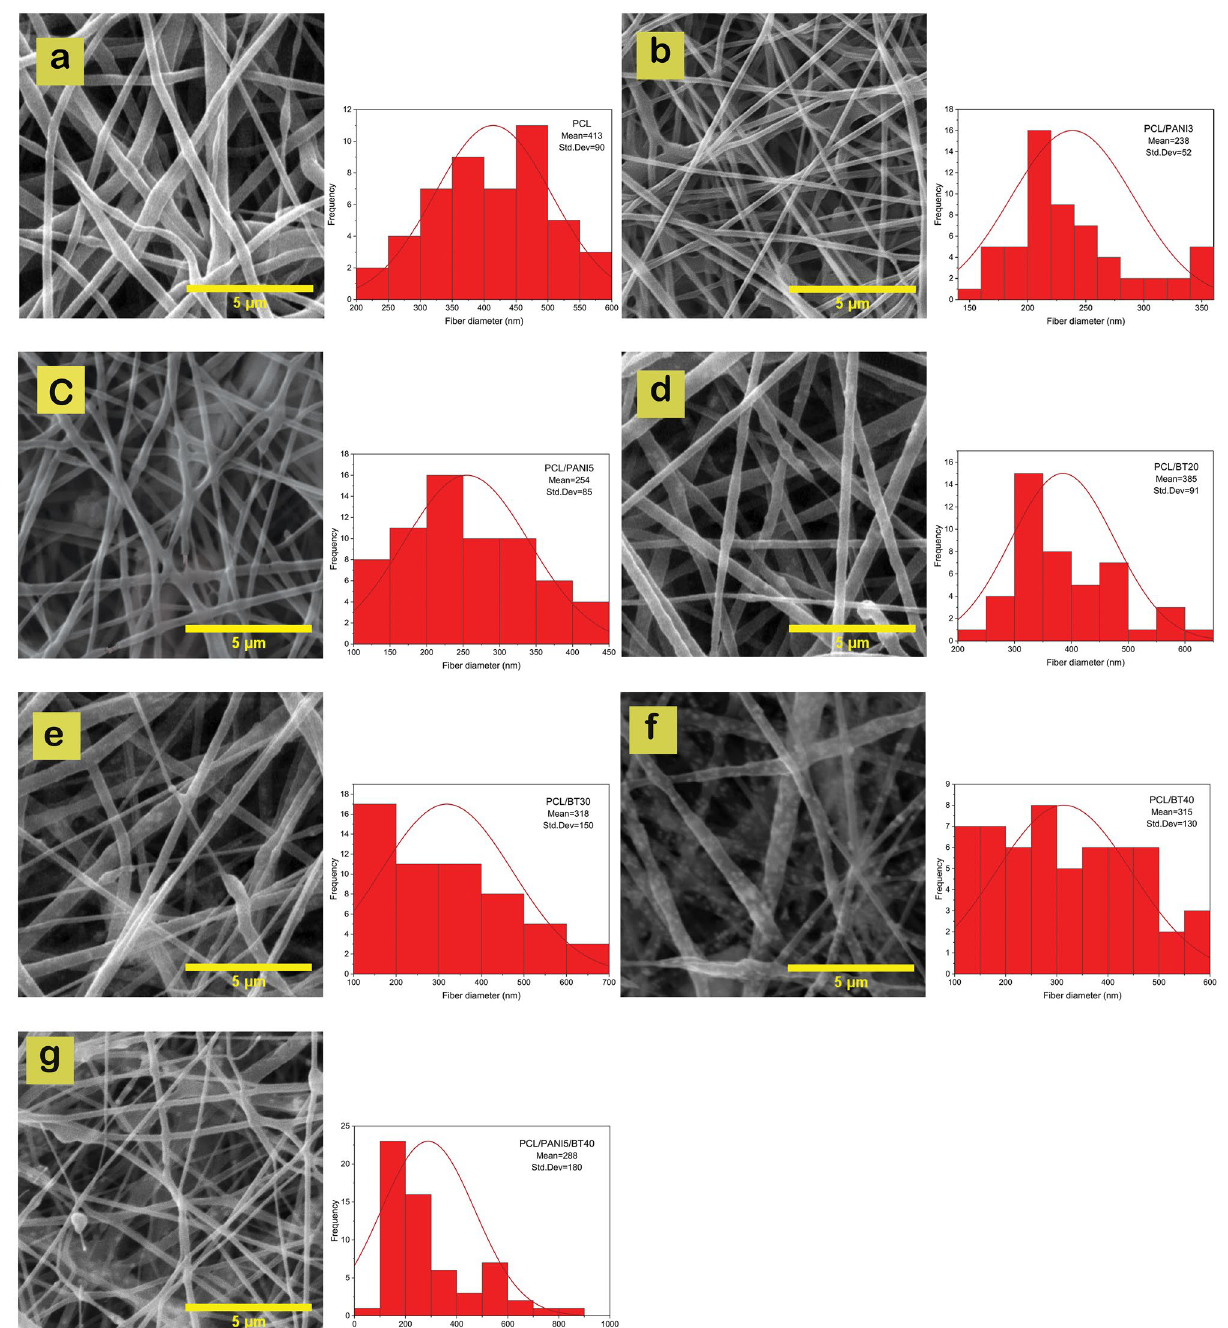
Figure 3. SEM micrograph of prepared scaffolds: ( a ) PCL (413 ± 90 nm average diameter), ( b ) PCL/PANI3 (238 ± 52 nm average diameter), ( c ) PCL/PANI5 (254 ± 85 nm average diameter), ( d ) PCL/BT20 (385 ± 91 nm average diameter), ( e ) PCL/BT30 (318 ± 150 nm average diameter), ( f ) PCL/BT40 (315 ± 130 nm average diameter), and ( g ) PCL/PANI5/BT40 (288 ± 180 nm average diameter) with respective fiber diameter distribution histograms. Results showed that in ternary nanocomposite PCL/PANI5/BT40, PCL nanofibers containing the PANI and BT NPs were homogeneously